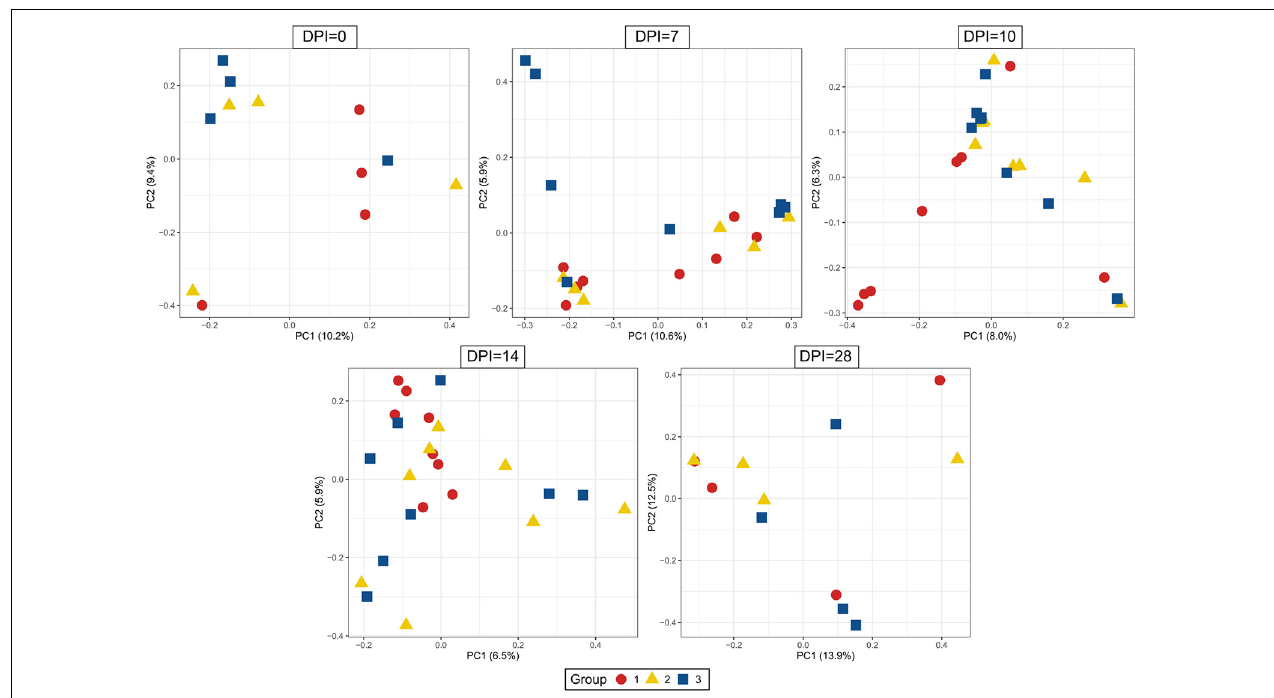
FIGURE 9 | Principal Coordinate Analysis (PCoA) of beta diversity using Bray-Curtis distances. Each dot corresponds to one bird. Group 1, infected with H. meleagridis + lux -tagged E. coli ; Group 2, infected with lux -tagged E. coli ; Group 3, negative control. dpi denotes for days post H. meleagridis infection.